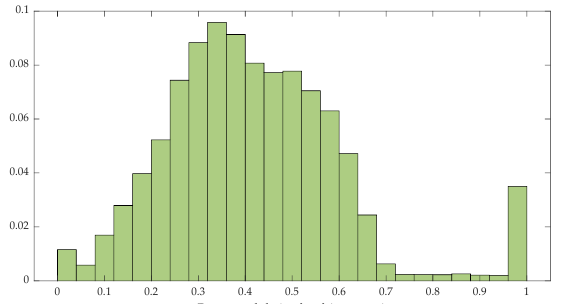
Figure 16. Normalized distribution of modulation levels when the pump is on (38% of time over the year). Bin width: